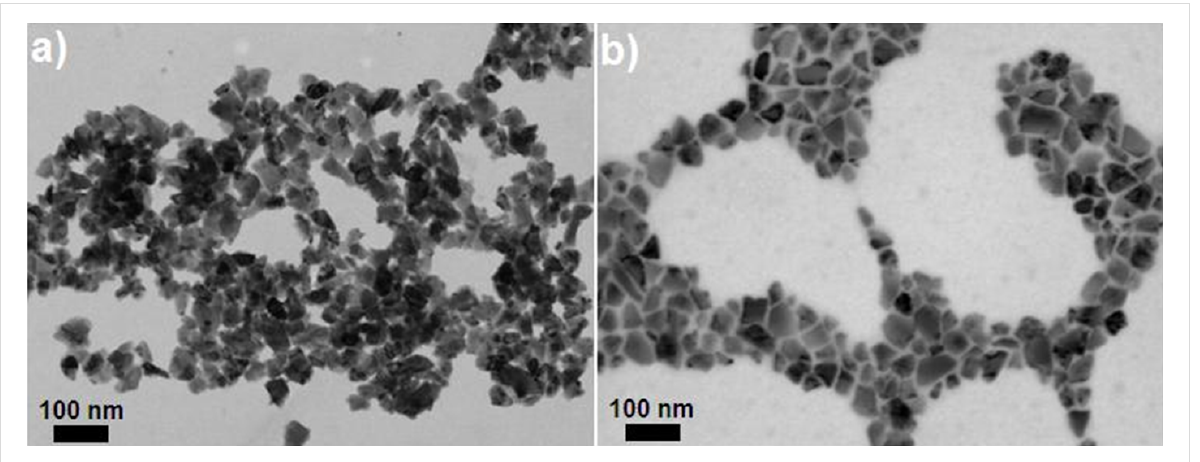
Figure 4: STEM images of a) pristine ND50 and b) ND50-PG.